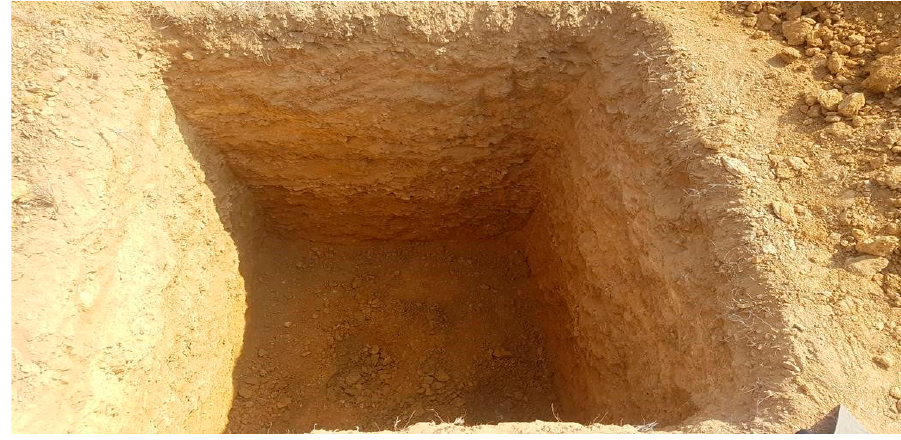
Figure 1. ( a ) Permeability apparatus and ( b ) modified permeability apparatus.